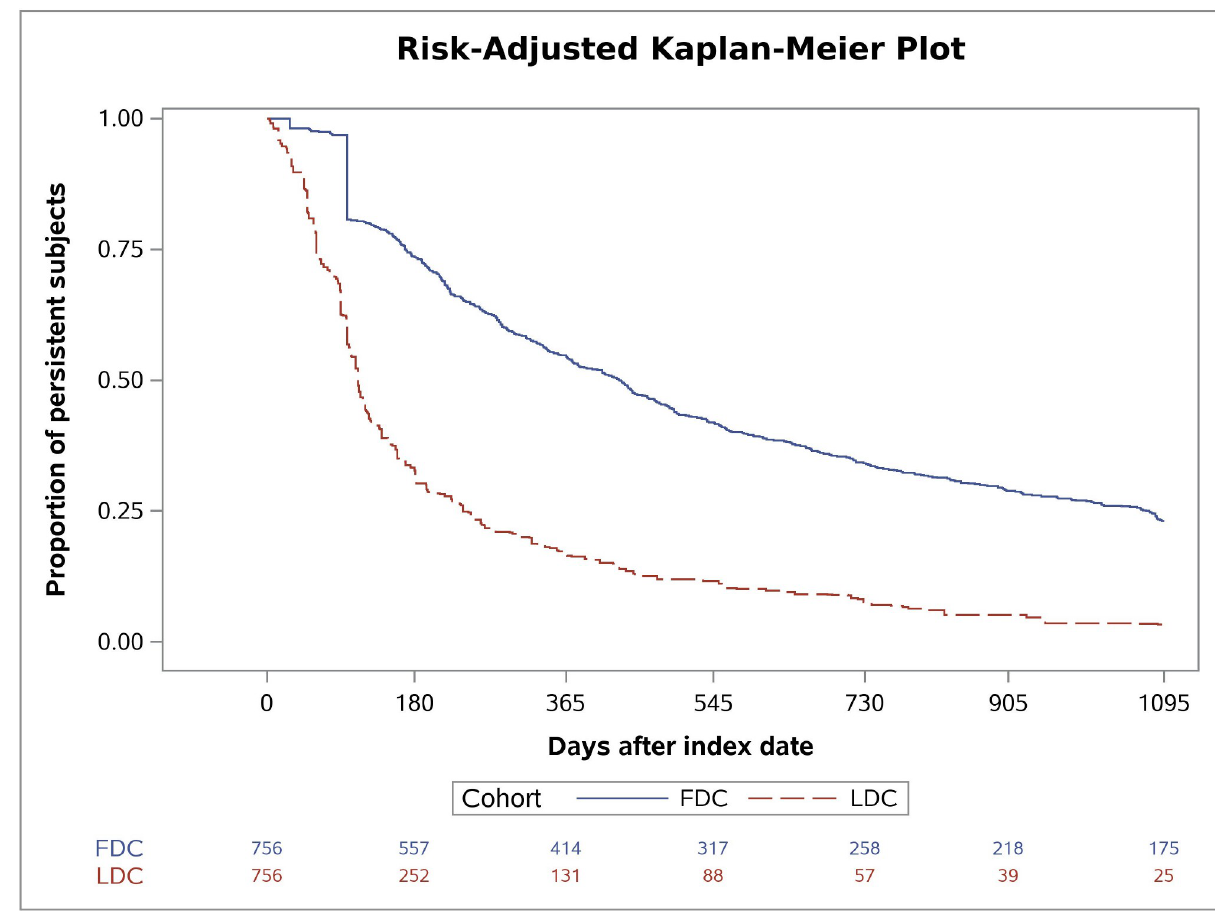
Fig 2. Risk-adjusted Kaplan-Meier plot. Weighted Kaplan-Meier curves displaying the proportion of individuals without discontinuation of treatment in the fixed-dose combination (FDC) and loose-dose combination (LDC) cohort.